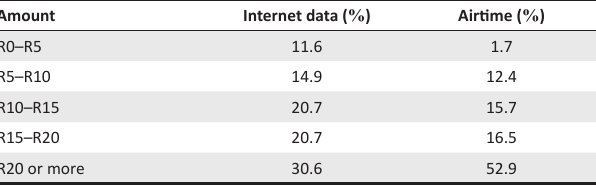
TABLE 2: Money spent per week by percentage of population on Internet bundles and airtime. Amount Internet data ( % )